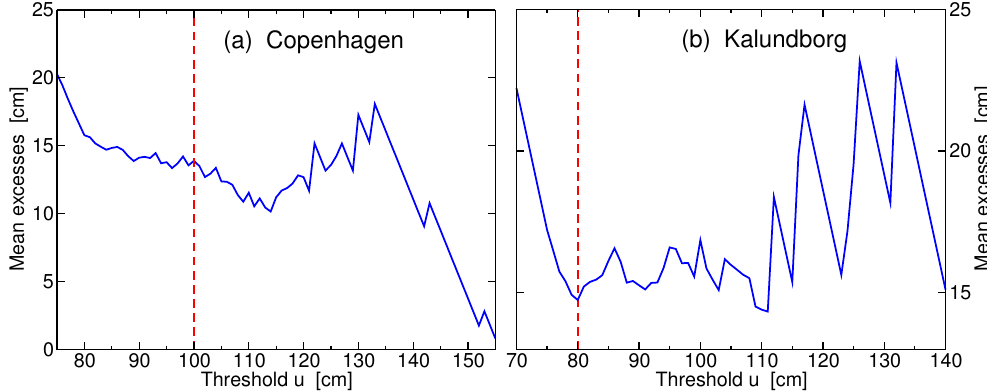
Figure 3. Average magnitudes of excesses over the threshold u from available sea level records for varying thresholds in (a) Copenhagen and (b) Kalundborg. The dashed red lines represent the thresholds u = 100cm (Copenhagen) and u = 80cm (Kalundborg), which were used for our